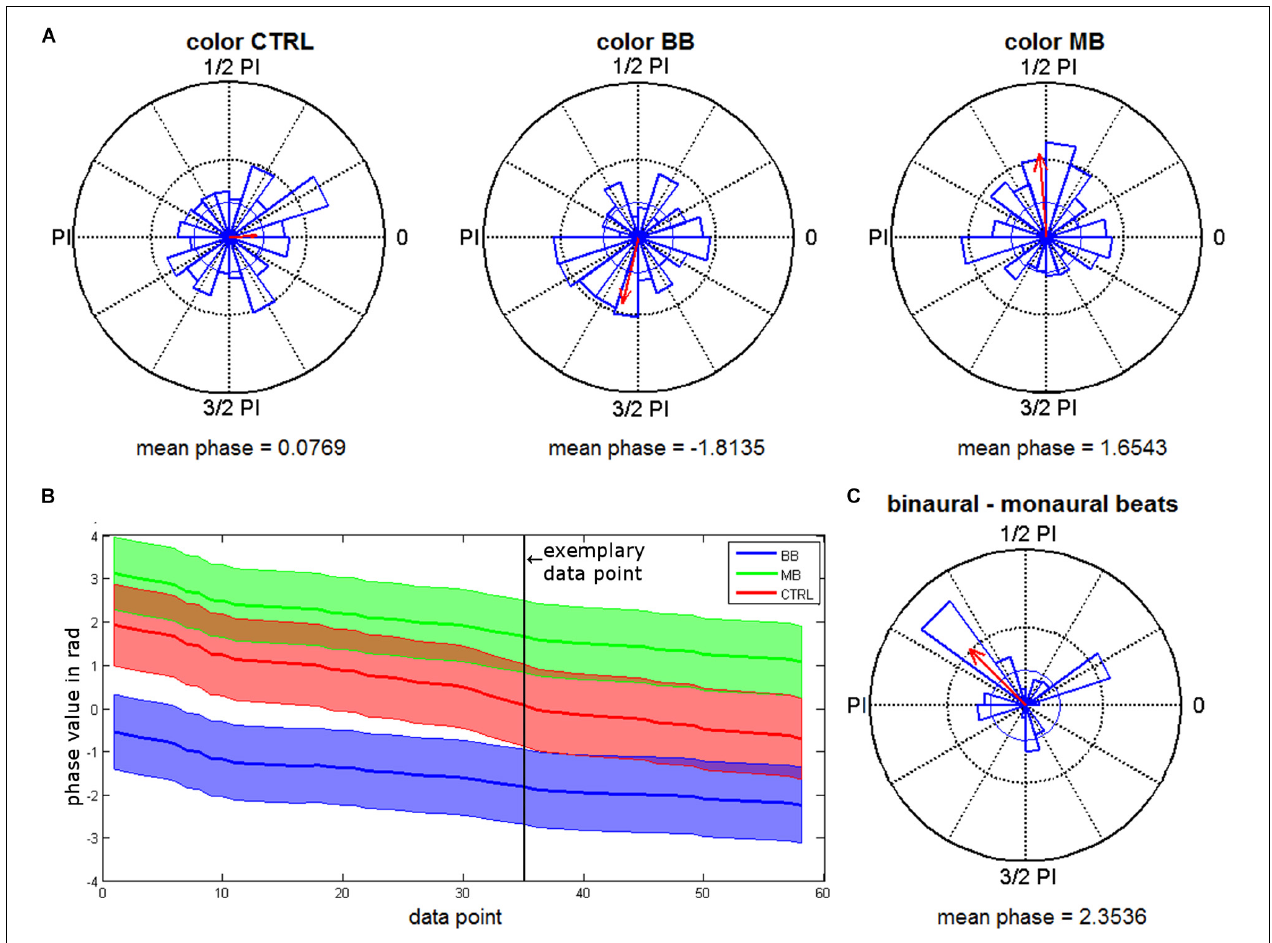
FIGURE 4 | Phase distributions for the different beat stimulation conditions. (A) Phase distributions from a time point with significant Rayleigh and Kruskal-Wallis tests (663 ms). Red arrows give the mean resultant vector with a scaled length (the inner circle indicates the vector length corresponding to a p -value of 0.05). (B) Mean phase values of all time points with significant Rayleigh and Kruskal-Wallis tests for binaural (BB) and monaural (MB) beat conditions and control (CTRL) condition (encoding) are shown. Shaded areas indicate circular variance. The exemplary data point marked shows the time point chosen for plot in (A) . (C) Phase differences between binaural and monaural beats during encoding (time points with significant Rayleigh and Kruskal-Wallis